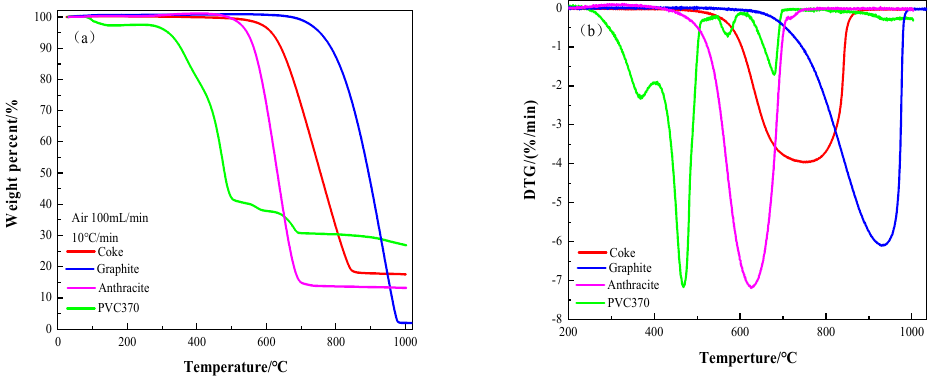
Figure 10. Combustion curves of each carbonaceous material: ( a ) weight loss curves, ( b ) weight loss rate